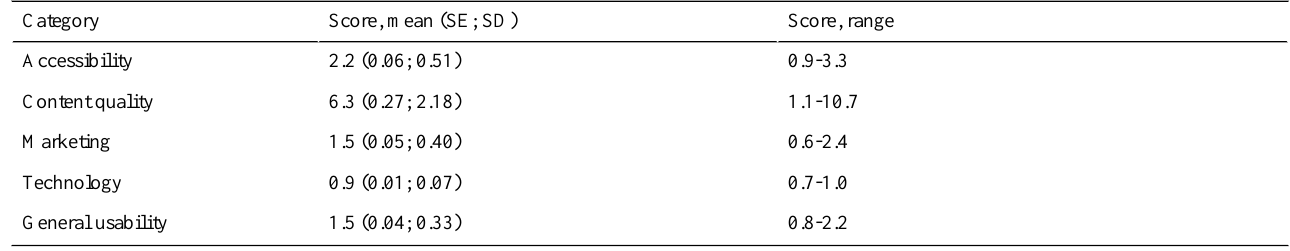
Table 1. Digital health center website summary statistics from the usability analysis.